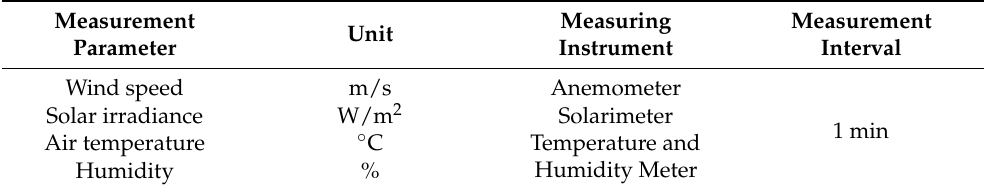
Table 1. Measurement parameters and instruments. Measurement